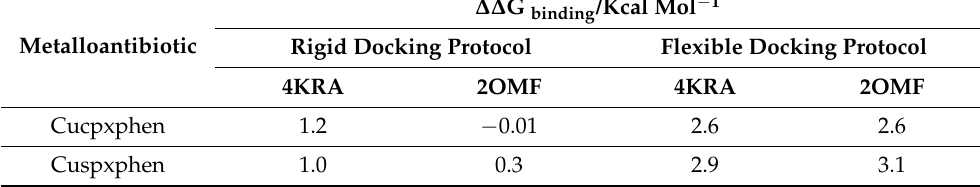
Table 3. ∆∆ G binding for the docking of Cucpxphen and Cuspxphen with the OmpF protein using a docking box adjusted to the constriction zone of the channel. Reproduced from [39] with permission from the Royal Society of